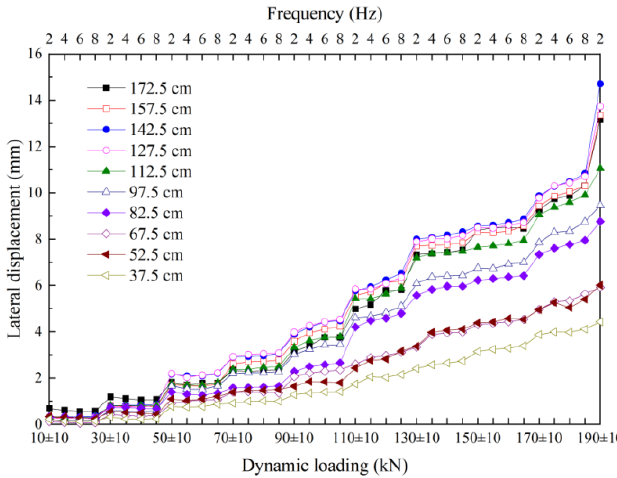
Figure 8. Variation in lateral displacement and frequency.